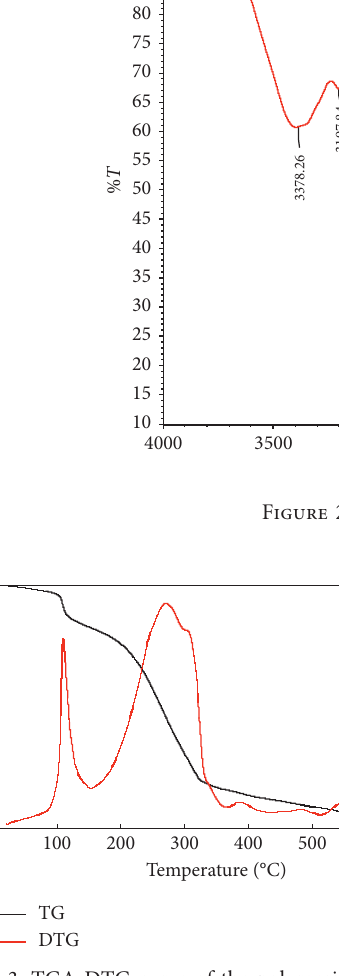
Figure 3: TGA-DTG curve of the polymeric